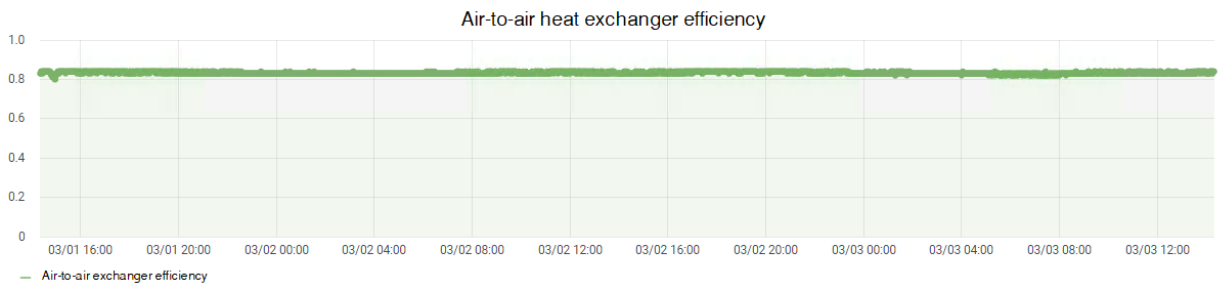
Figure 11. The efficiency of